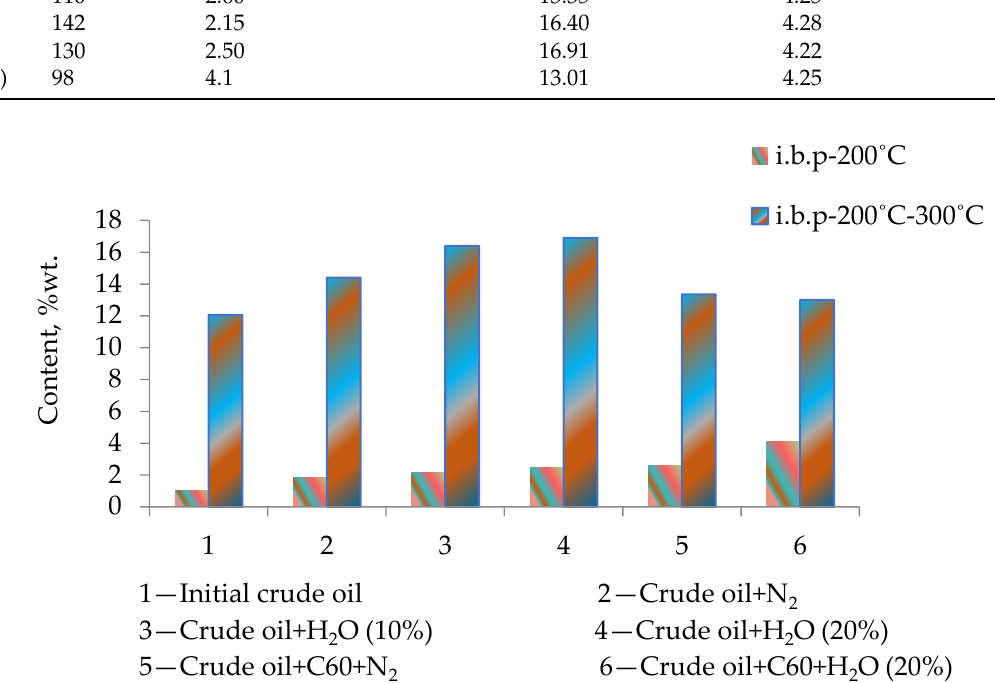
Figure 3. The contents of light distillate fractions before and after thermolysis. The chemical and structural composition of heavy oil can be indirectly evaluated by the density of the oil and petroleum products. Hence, in Figure 4, we present the density of the initial crude oil sample and its fractions (i.b.p.–200 ◦ C and 200 ◦ C–300 ◦ C) and the thermolytic and aquathermolytic products in the absence and presence of fullerene C60.